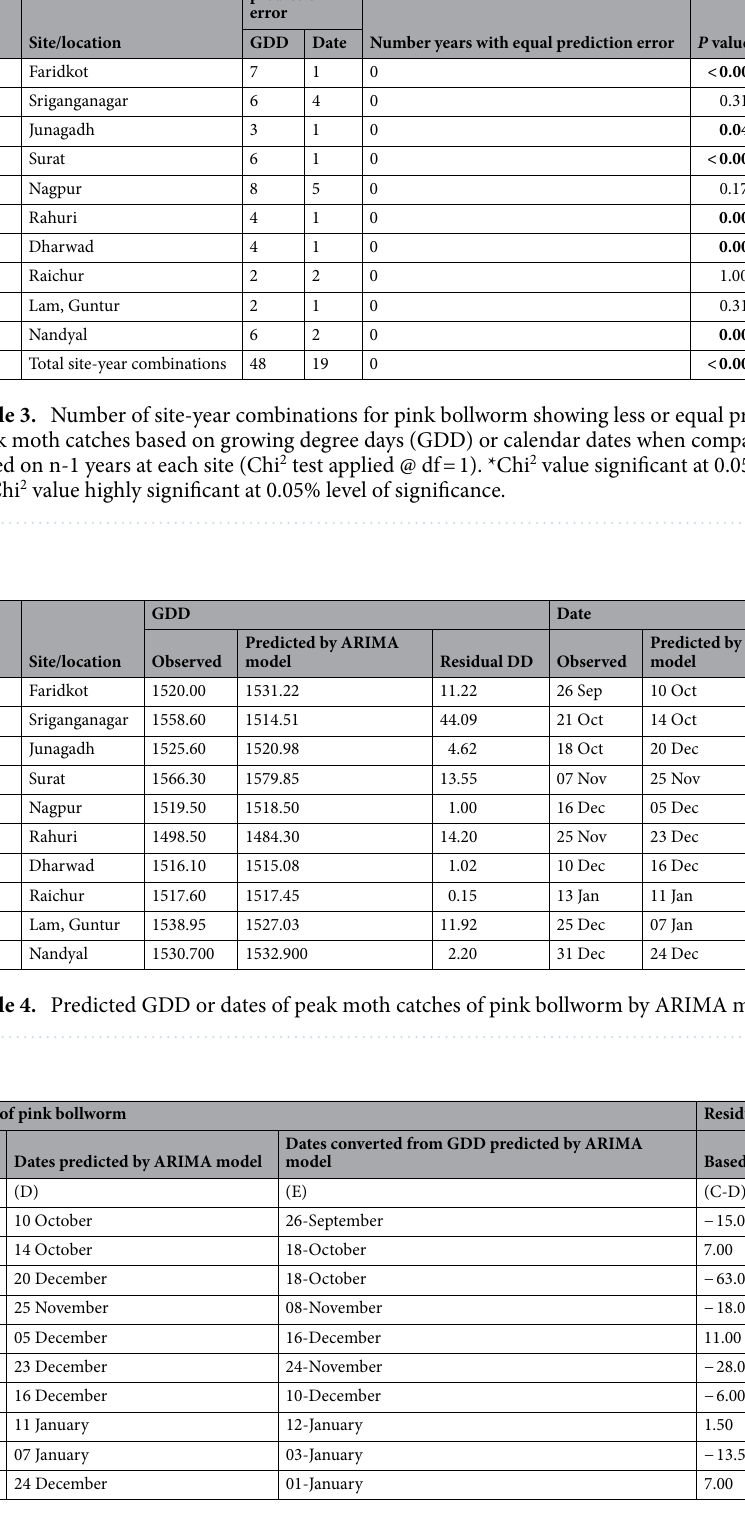
Table 5. Predictive ability of GDD vs calendar dates in forecasting the dates of peak moth emergence as revealed from ARIMA model applied to the trap catch data for all the years at each location.